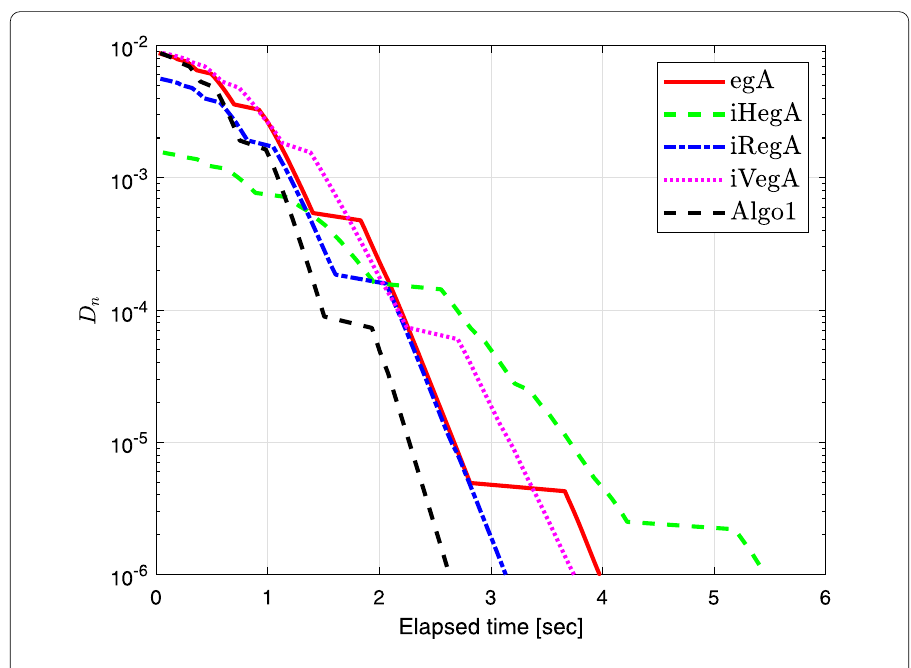
Figure 12 Example 5.2 when x –1 = x 0 = y 0 = (2, ... ,2 500 ,0, ... )